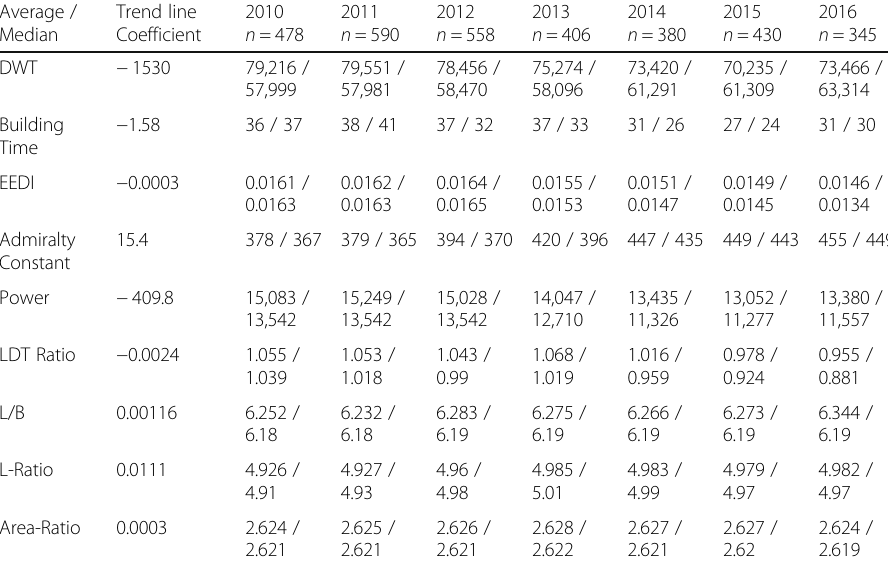
Table 3 Development in ship quality variables over time Average /